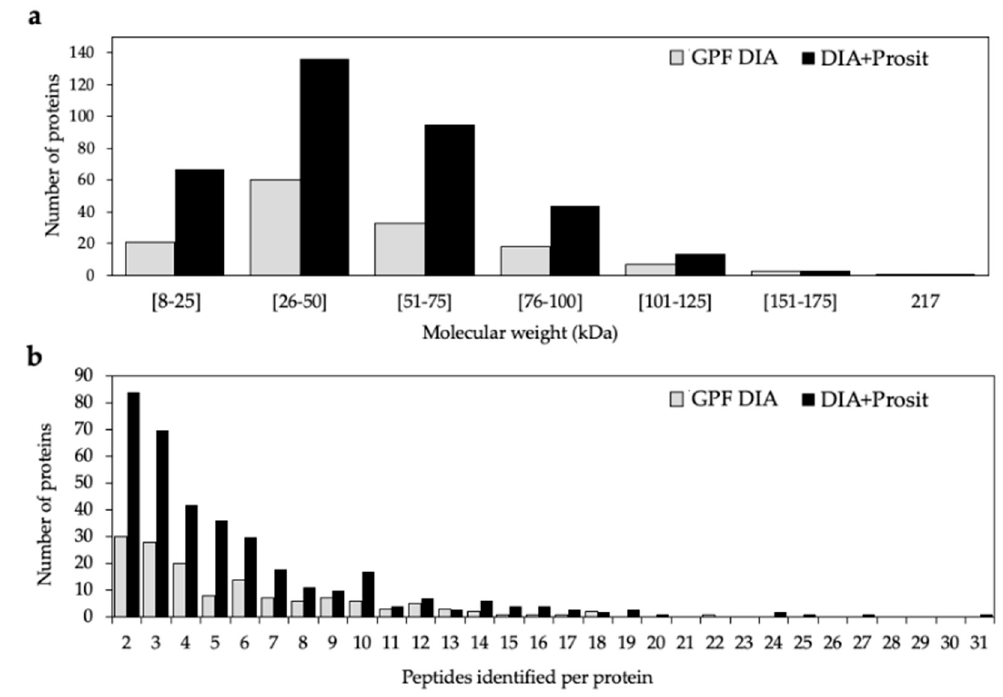
Figure 3. Distribution of the total number of V. vinifera proteins identified by GPF DIA and DIA + Prosit by ( a ) molecular weight (kDa) ranging from eight to 217 kDa. ( b ) Identified peptides varying from two to 31 peptides per protein. Predicted proteins with only one peptide were discarded.